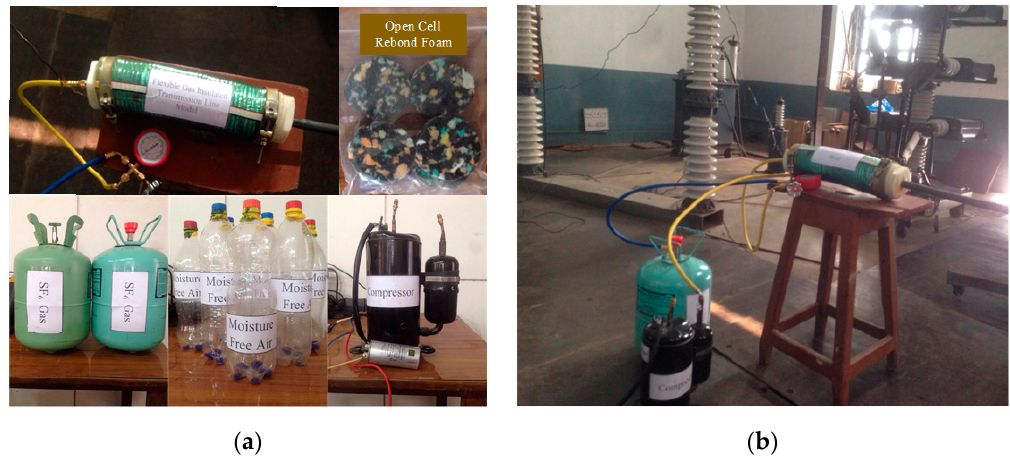
Figure 19. ( a ) Different components used in the discharge tests and ( b ) the experimental setup for lightning impulse and disruptive discharge tests.